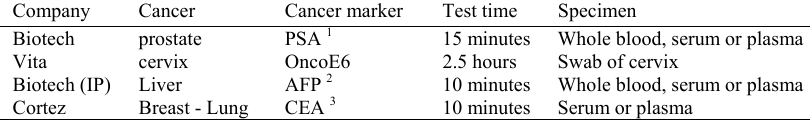
Fig. 1. Different size of cancer cells; (a) Breast cancer, (b) Lung cancer, (c) Prostate cancer [19] Table 1: Some useful biomarkers for diagnosing cancer in manufacturing kits[26]. Table 1: Some useful biomarkers for diagnosing cancer in manufacturing